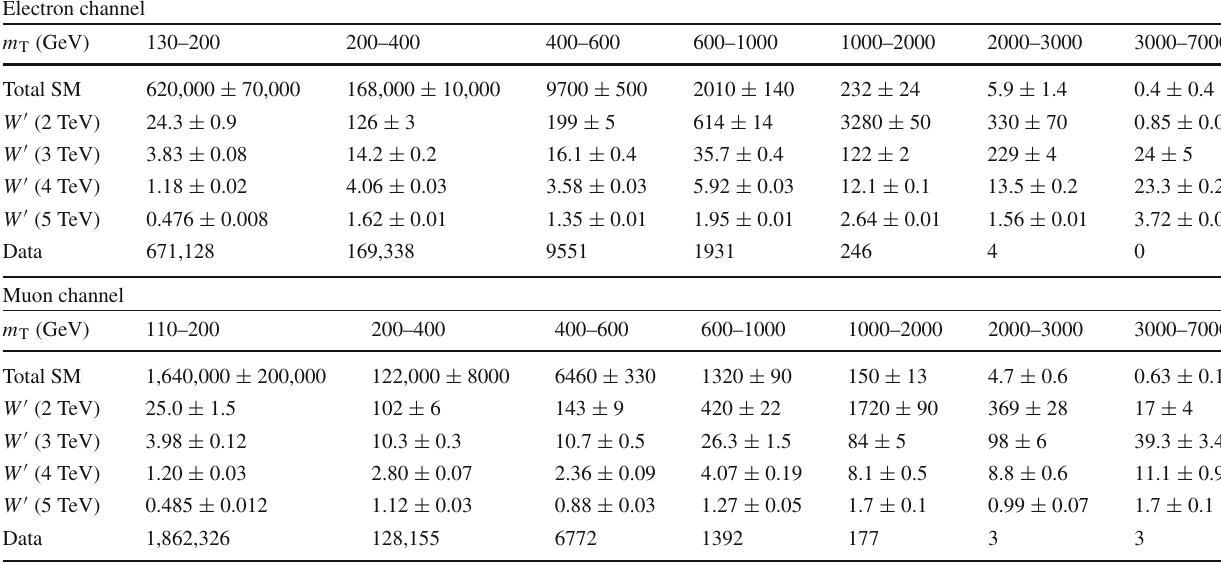
Table1 ThenumbersofexpectedeventsfromthetotalSMbackground and SSM W (cid:2) signal and the numbers of observed events in data in the electron (top) and muon (bottom) channels in bins of m T . The uncer-